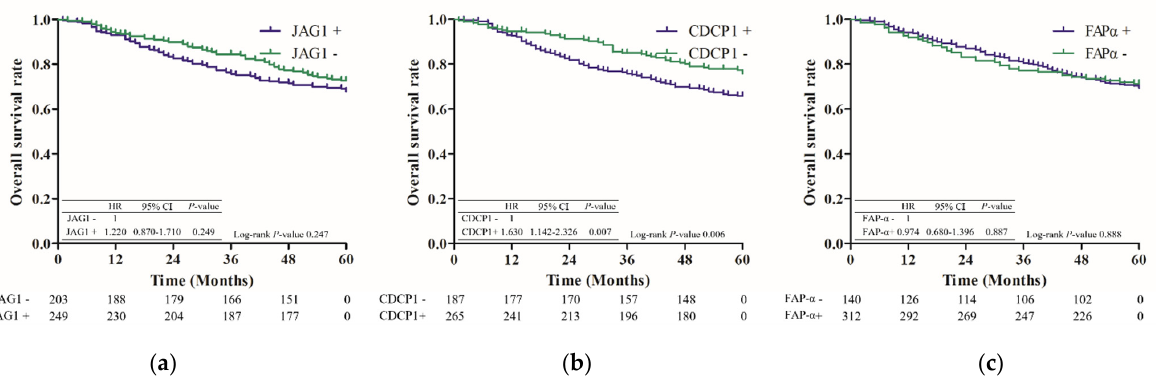
Figure 3. Five-year overall survival according to biomarker expression. ( a ) JAG1; ( b ) CDCP1; ( c ) FAP- α . Table 4. Cox regression analysis for recurrence within 5 years after surgery in stage I non-small-cell lung cancer. Univariate Analysis Multivariate Analysis